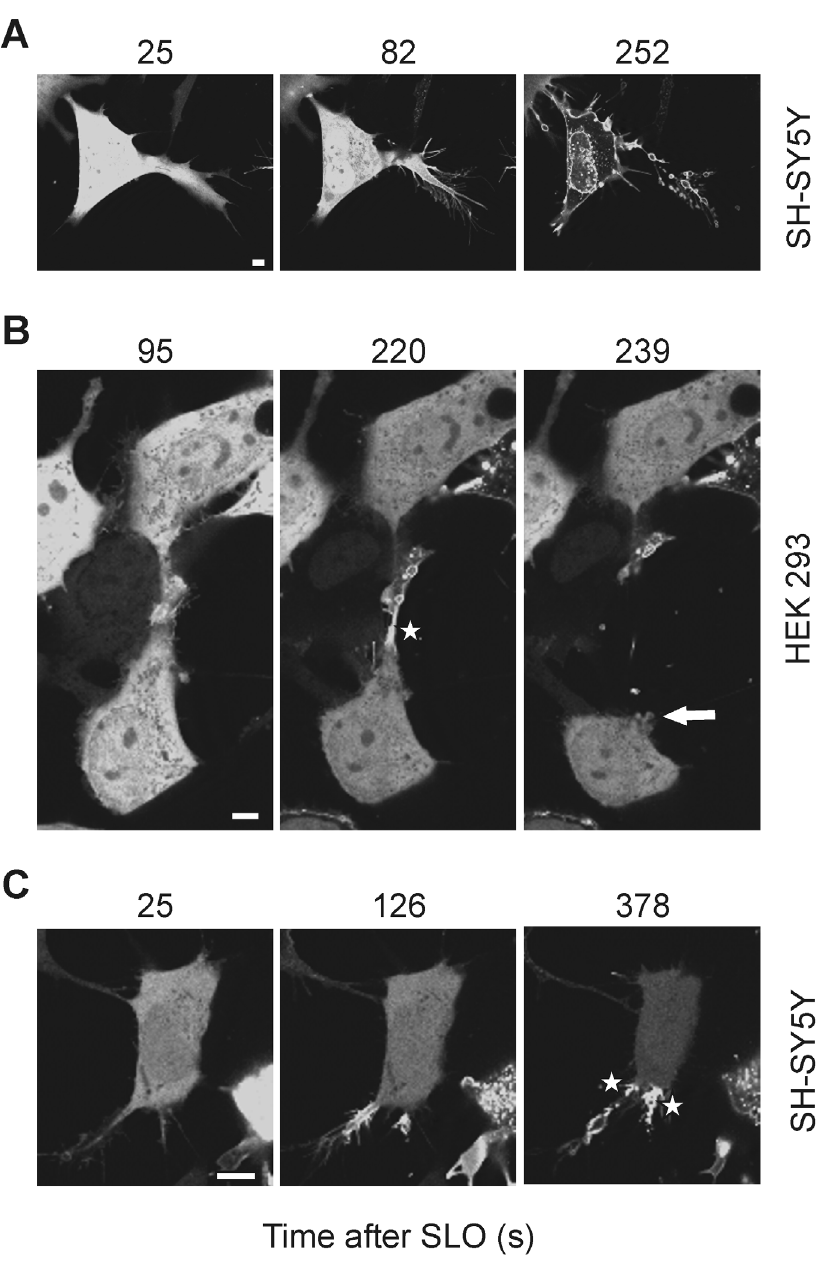
Figure 6. Self-inflicted mechanical damage in SLO-perforated cells. ( A–C ) The SLO-perforated protrusions of SH-SY5Y or HEK 293 cells are wrenched apart by mechanical forces. ( A ) The global translocation of annexin A1-YFP manifests cell lysis. ( B,C ) The cytoplasmic localization of annexin A1-YFP within the cell body is evidence of successful resealing of the plasmalemma. The arrow in ( B ) points at the resealed base of the destroyed protrusion. The asterisks in (B, C ) denote regions of clear demarcation between permeabilized (plasmalemmal localization of annexin A1- YFP) and non-permeabilized (cytoplasmic localization of annexin A1-YFP) cellular compartments. Magnification bars=5 m m.